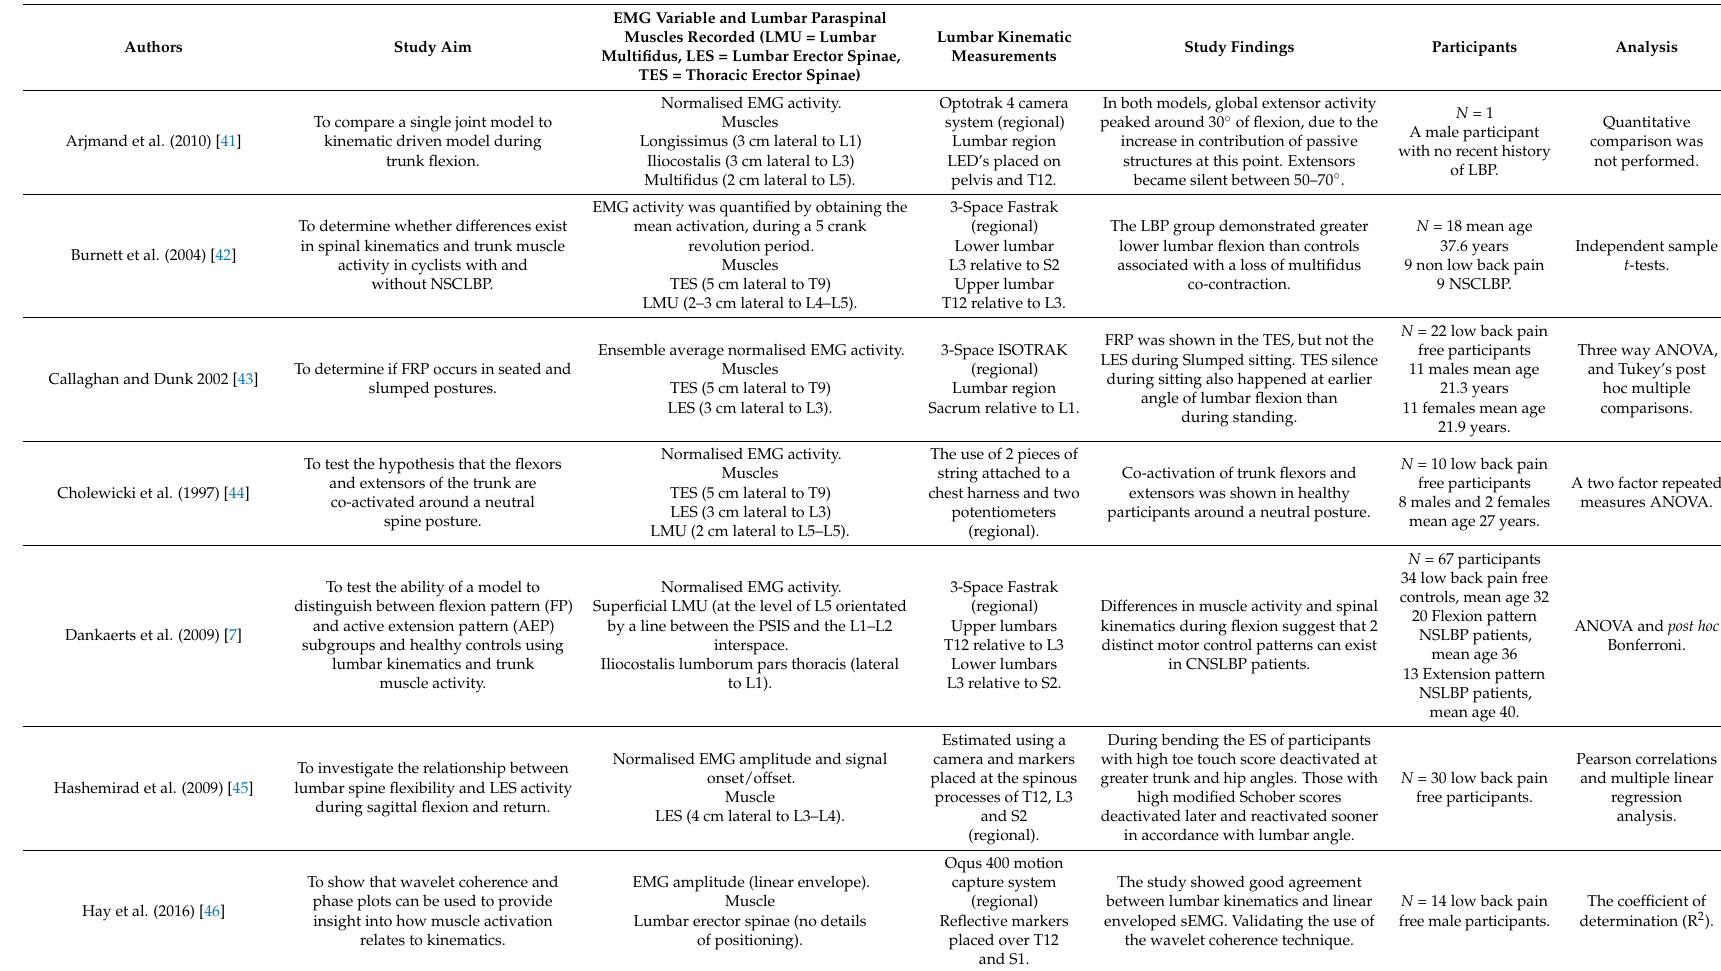
Table 4. Study characteristics ( N =